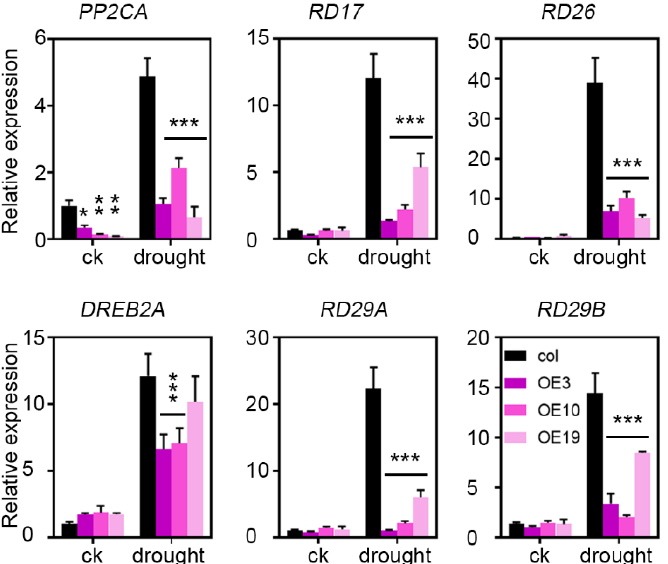
Figure 8. Expression levels of drought-stress-related genes in ZmLBD5 transgenic Arabidopsis: Total RNA was isolated from 15-day-old seedlings grown without (CK) or with 250 mM mannitol treatment for 7 days. Transcript levels of PP2CA , RD17 , RD26 , DREB2A , RD29A , and RD29B in the transgenic lines and wild type were determined by qPCR, using AtACTIN8 and AtUBQ10 as reference genes. Fold change was calculated by 2 − ∆∆ t . Significance was analyzed by one-way ANOVA. * p < 0.05; ** p < 0.01; *** p < 0.001. All bars represent means ± SD ( n = 3).